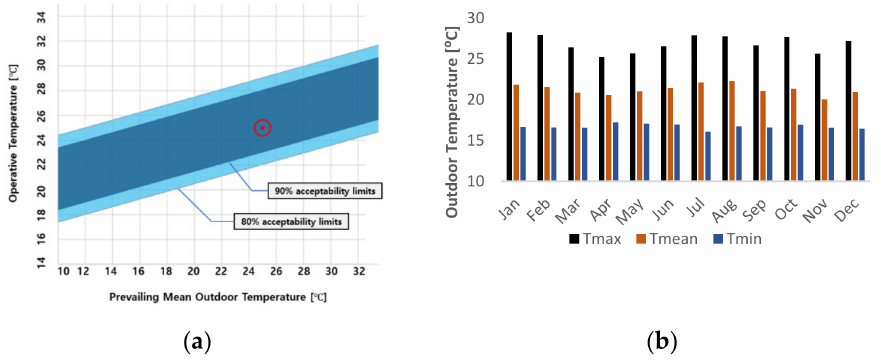
Figure 3. ( a ) Adaptive comfort zone per the ASHRAE 55-2010 standard; ( b ) Kigali’s outdoor temper- ature variation through the